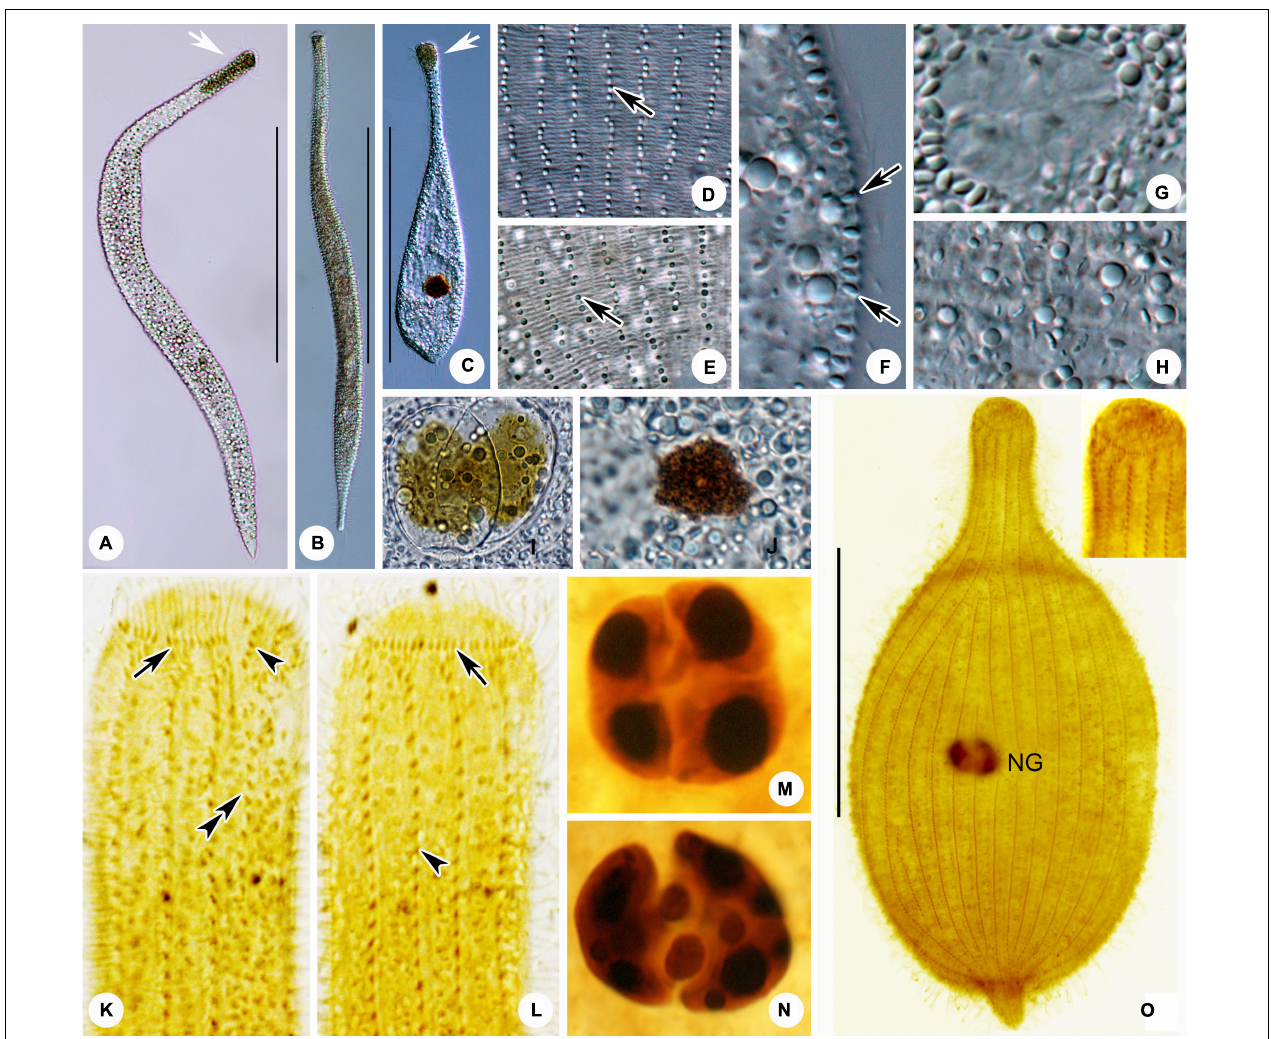
FIGURE 10 | (A–O) Tracheloraphis colubis in vivo (A–J) and after protargol staining (K–O) . (A,B) Typical individuals. Arrowhead showing the head of cell. (C) An extremely contracted cell. Arrowhead showing the head of cell. (D,E) Distribution of cortical granules between somatic kineties (arrow). (F) Lateral view, showing the elliptical cortical granules at the cell margin (arrows). (G) Nuclear group. (H) Showing granules in cell. (I,J) Showing algae in the food vacuole. (K,L) Detailed ciliature of left (K) and right (L) side of anterior body region. Arrow in (K) showing circumoral kinety, arrowhead showing brosse, double arrowheads showing bristle kinety. Arrow in (L) showing circumoral kinety, arrowhead showing somatic kinety. (M,N) Nuclear group. (O) Overview showing ciliary pattern. NG, nuclear group. Scale bars = 300 µ m (A–C) ; 100 µ m (O)